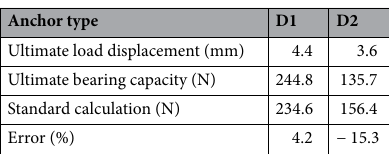
Table 2. Maximum uplift loads and failure time of soil